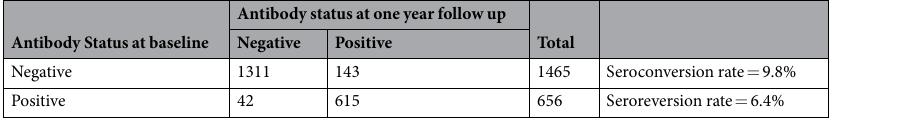
Table 2. Change in antibody status over time in longitudinal cohort of children ages 1–9 years.